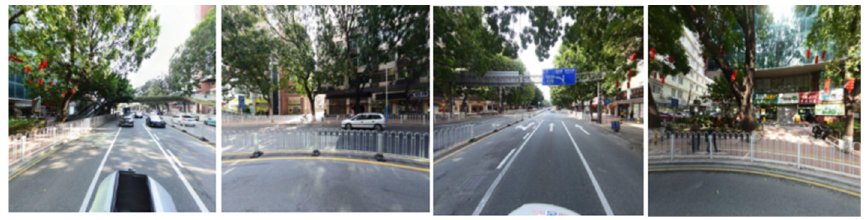
Figure 5. Street Expanded View (0°, 90°, 180°, 270° from Left to Right).